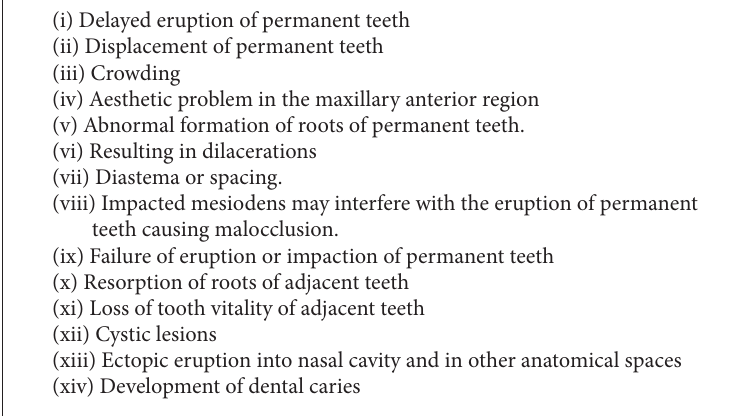
Box 2: Complications that are associated with